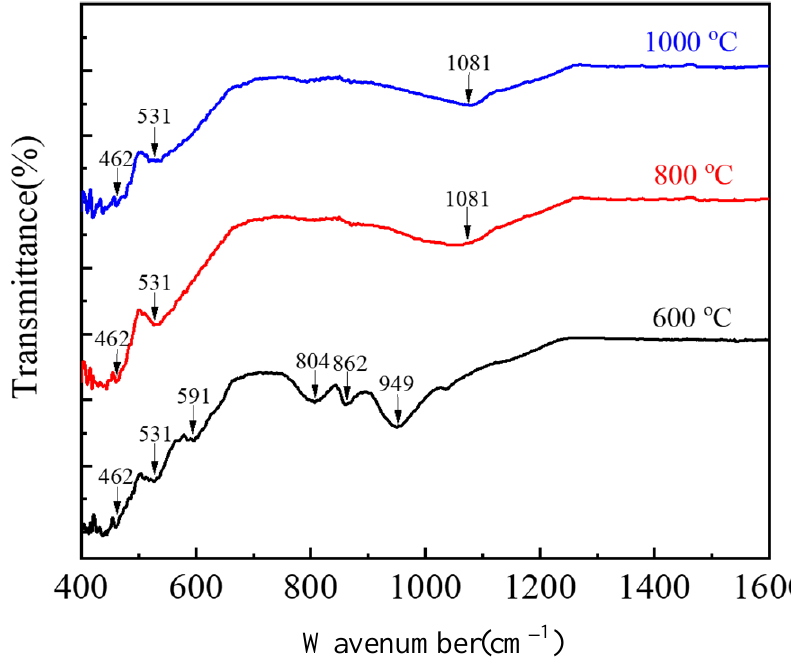
Figure 11. FTIR pattern of copper slag in different temperature gradient.